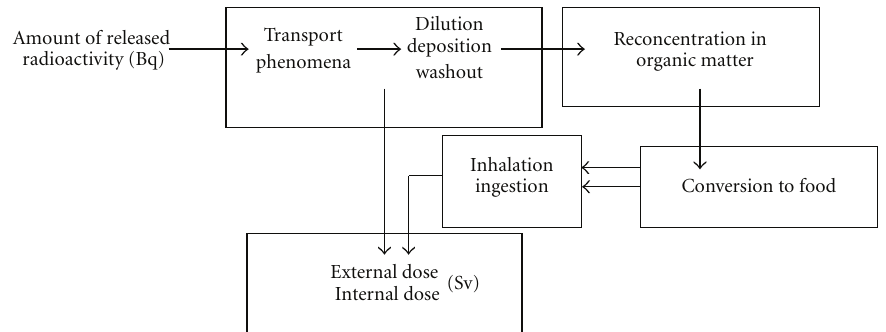
Figure 5: Simplified flow-path: from radiation (Bq) to doses